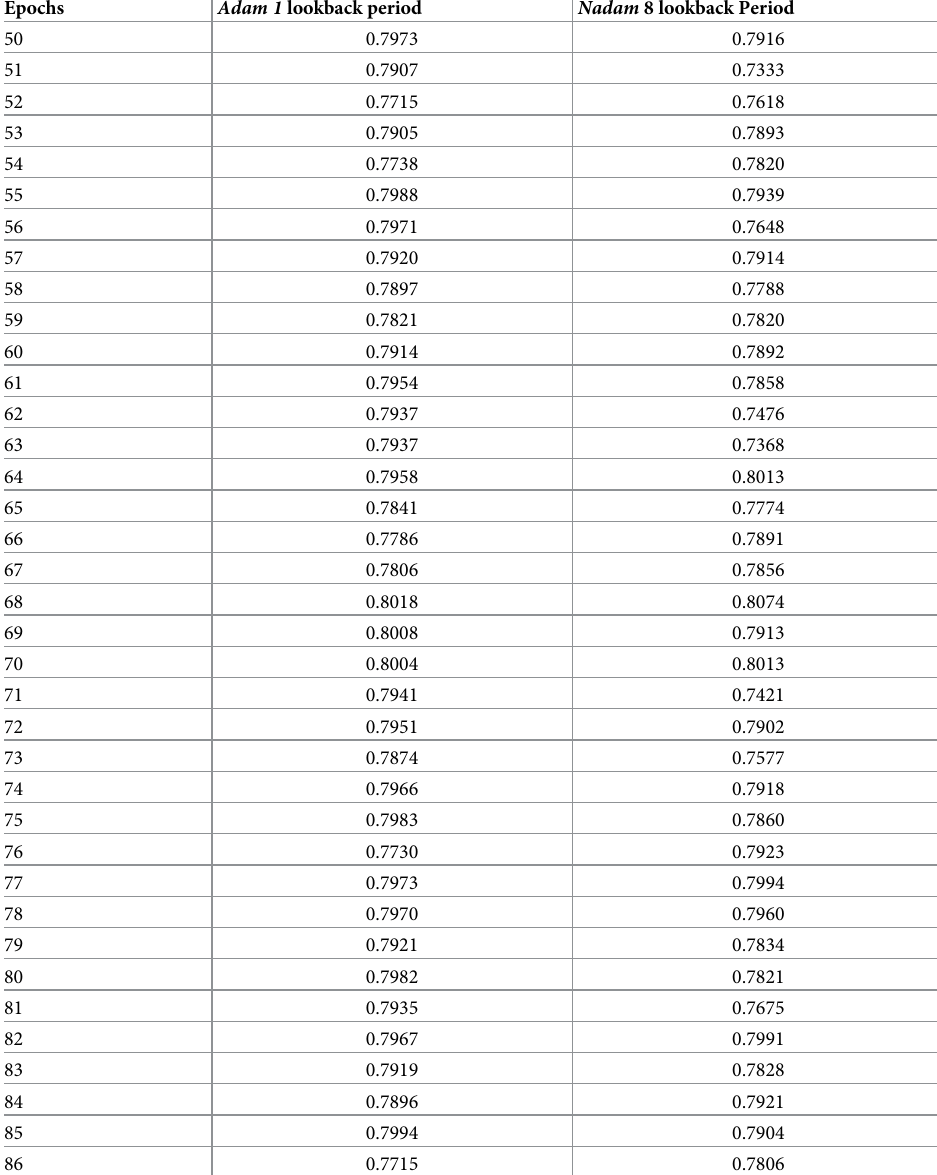
Table 6. Adam and Nadam epochs